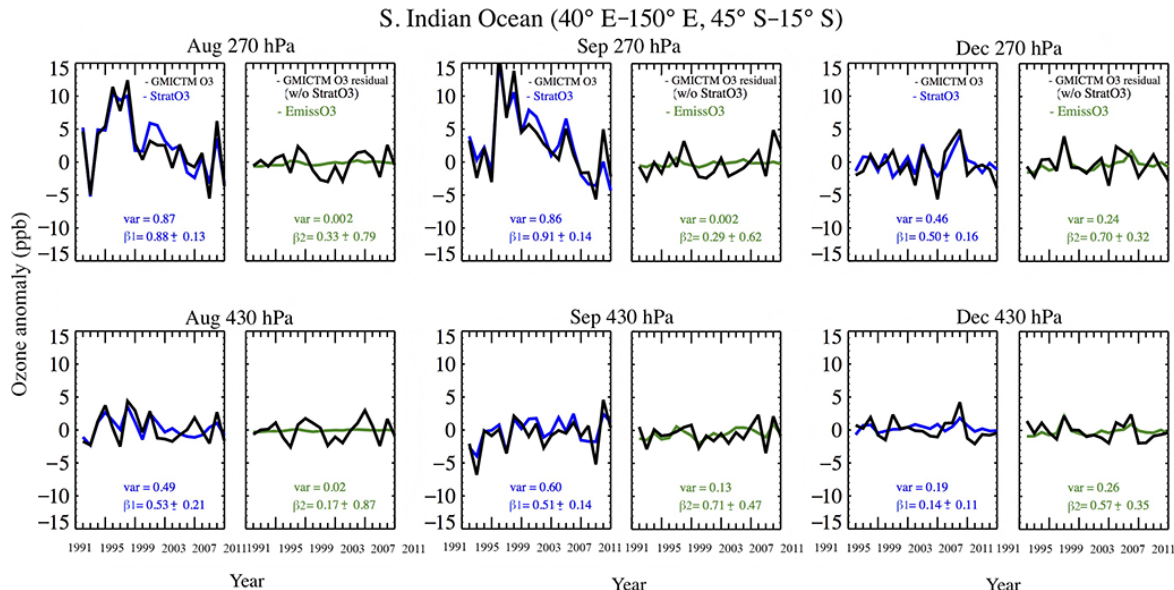
Figure 11. The multi-regression results of simulated ozone anomalies over the South Indian Ocean region relying on two predictor variables: StratO 3 (blue) and EmissO 3 (green) at 270 and 430hPa. Three panels show results from August (left), September (middle), and Decem- ber (right) from 1992 to 2011. Each panel contains two columns. The left column of each panel compares the anomalies of StratO 3 (blue) and simulated ozone mixing ratio (black) from the GMI-CTM model at 270 and 430hPa. The right column compares the simulated O 3 residual after removing the regression from StratO 3 (black line) and EmissO 3 (green line) at these two levels. EmissO 3 is calculated from the difference of simulated ozone between the run with yearly-varied emission and the run with constant emission. Unit for y axis is parts per billion (ppb). The variance explained by each predictor (var), regression coefficient ( β) , and its 95% confidence level are labeled in each